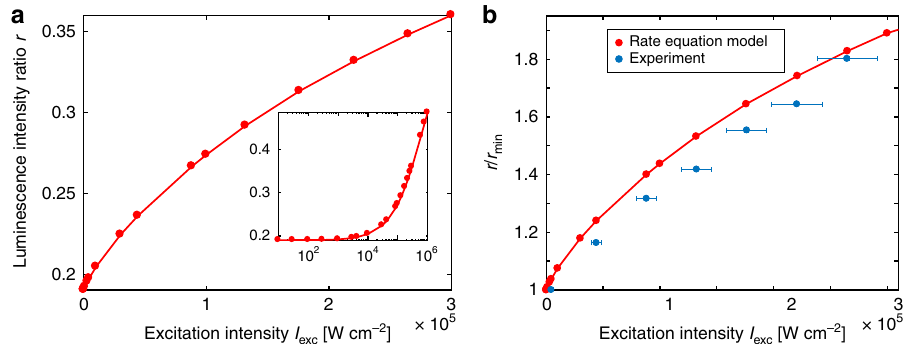
Fig. 5 Rate equation modeling. a Modeled r ( I exc ) using rate equation analysis at a constant temperature of T = 298 K. The main plot shows the results over the excitation intensity range used in the majority of our experiments. The inset shows the modeled r ( I exc ) over a larger I exc range. b Comparison of the measured (Fig. 2c, 296 K) and modeled relative increase in r with I exc . Both the modeled and measured r ( I exc ) show a similar percent increase, further con fi rming that this effect is non-thermal in nature and can largely be explained by radiative and non-radiative relaxation from higher-lying Er 3 + energy levels that become increasingly populated at higher I exc . Error bars in I exc for the experimental data are ±10% to account for decreased laser stability and greater measurement uncertainty at higher I